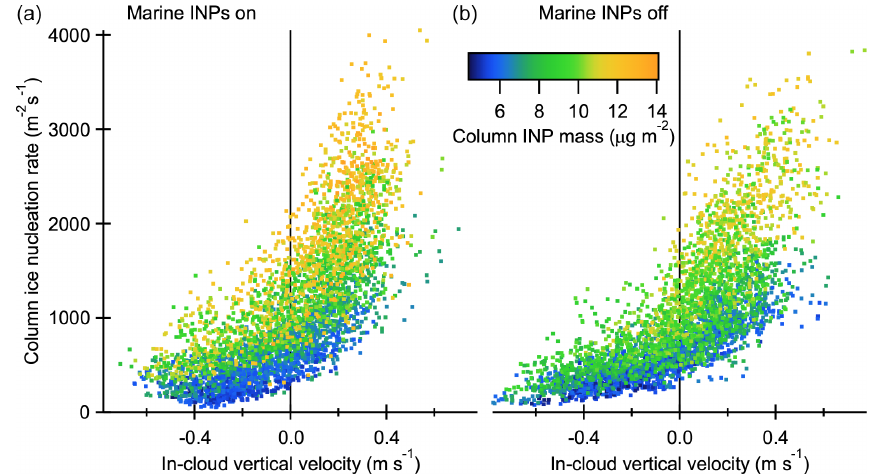
Figure 8. Vertically integrated ice nucleation rate (the number of primary freezing events per second in a column of air above 1m 2 of sea surface area) as a function mean in-cloud vertical velocity for each column from a single time step at 8h. Marker colour is based on vertically integrated INP mass mixing ratio (the total INP mass above 1m 2 of sea surface area). Simulations are with (a) and without (b) marine INPs and high background INP